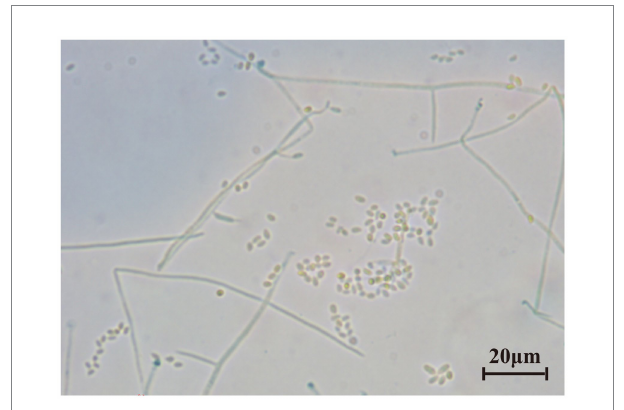
FIGURE 1 The microscopic morphology of tobacco-isolated strain. Scale bar = 20 μ